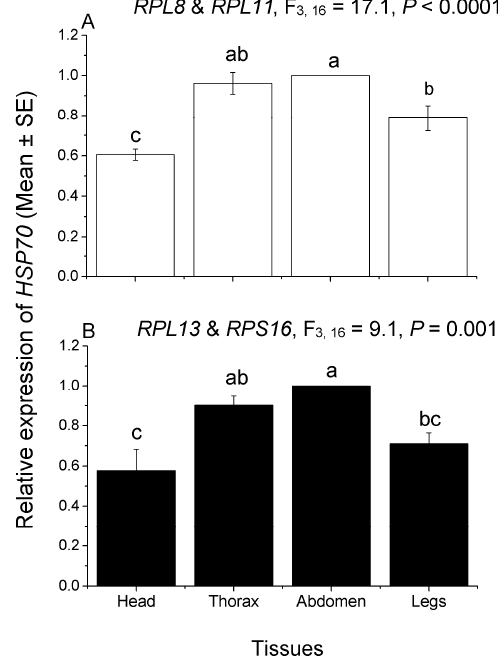
Figure 4. Tissue expression patterns of HSP70 gene in C. hemipterus . The relative expression levels of HSP70 in the head (including antennae and mouthparts), thorax, abdomen, and legs were normalized to the top two most stable (A, RPL8 and RPL11 ) and least stable (B, RPL13 and RPS16 ) candidate reference genes, respectively. Different lower letters above bars represent significant differences in gene expression among different tissues ( p < 0.05, Tukey’s HSD test).